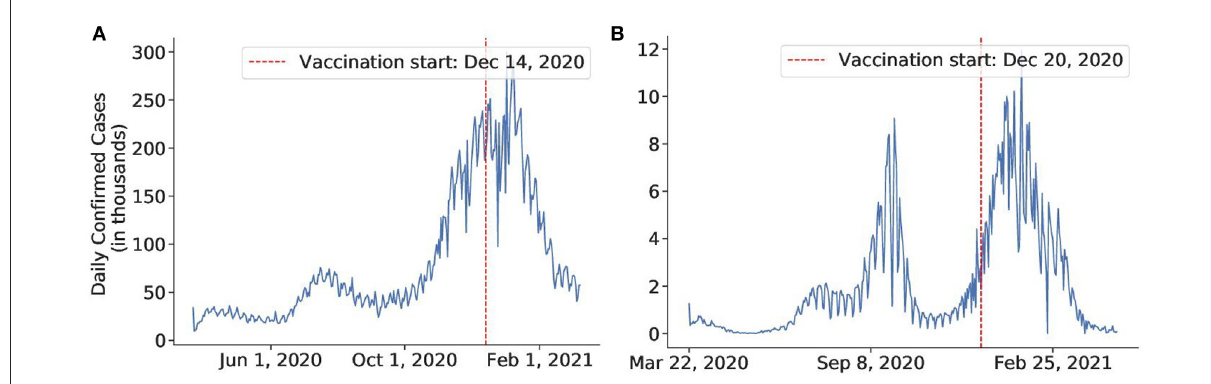
FIGURE3 The daily number of confirmed cases of the countries in a timeline in which we investigate the effect of vaccines. (A) United States, (B)